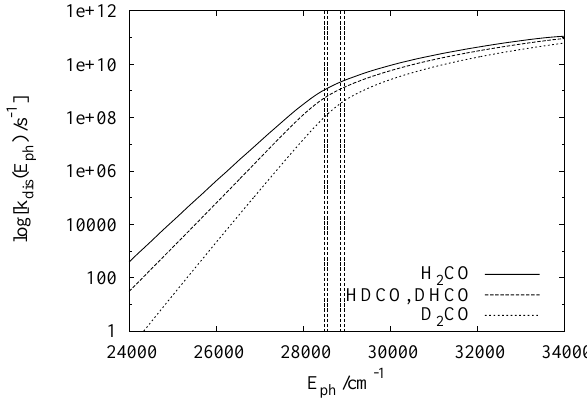
Fig. 3. Dissociation rate as a function of photon energy at T = 300K. The vertical lines mark the position of the barrier for dissociation; 28460cm − 1 (H 2 − CO), 28538cm − 1 (HD − CO), 28839cm − 1 (DH − CO) and 28940cm − 1 (D 2 −